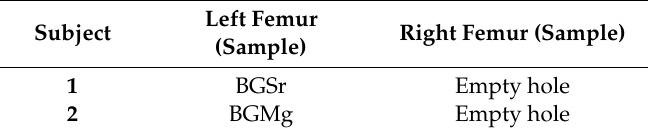
Table 2. Bioactive glasses implantation in rabbits’ left and right